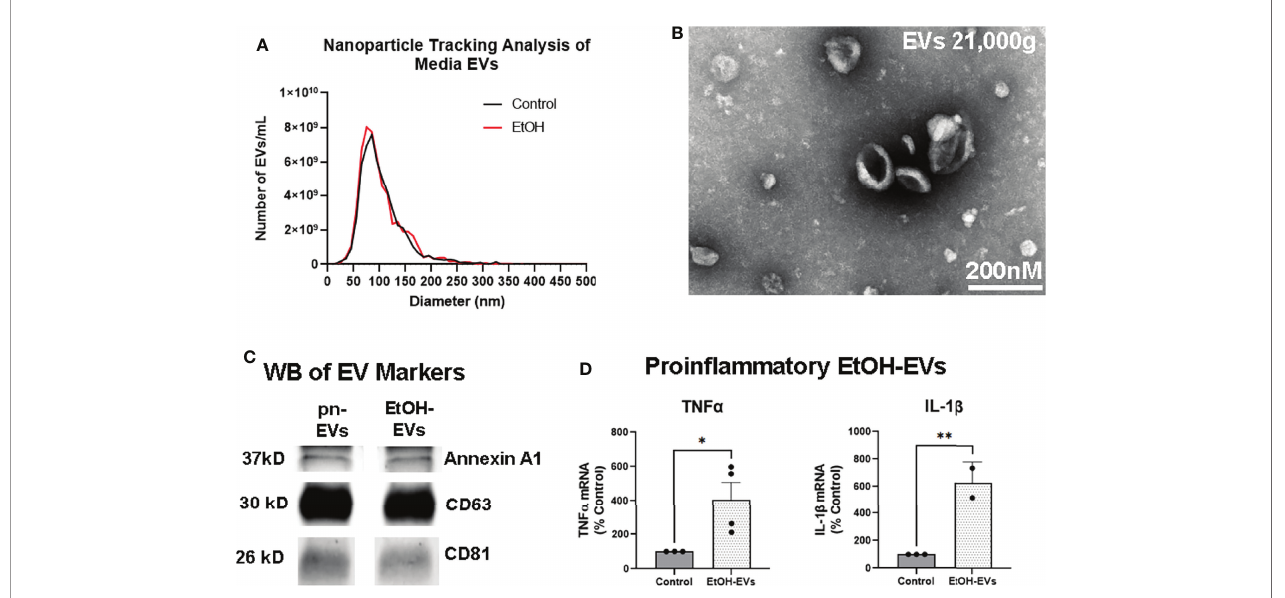
FIGURE 3 | EVs secreted by ethanol are proin fl ammatory. EVs were isolated from OBSC media after either ethanol (EtOH-EVs) or vehicle control (pro-neurogenic, pn-EVs). (A) NTA assessment of OBSC media showed similar size distributions between Control/pn-EVs and EtOH-EVs, mostly between 50-300nm in diameter. Averaged distributions from 3 samples per group depicted. (B) Transmitting electron microscopy con fi rmed the presence EVs with the expected size and cup- shaped morphology. (C) Western blot (WB) analysis of EV markers found Annexin A1, CD63, and CD81 in both pn-EVs and EtOH-EVs. (D) EtOH-EVs were transferred to naïve OBSC slices, and levels of proin fl ammatory cytokines in slices measured by RT-PCR. A signi fi cant main effect of treatment was found (One-way ANOVA F 3,8 = 9.211, p= 0.0055). EtOH-EVs caused robust inductions of TNF a (4-fold) and IL-1 b (6-fold), * p < 0.05, ** p < 0.01 Sidak ’ s